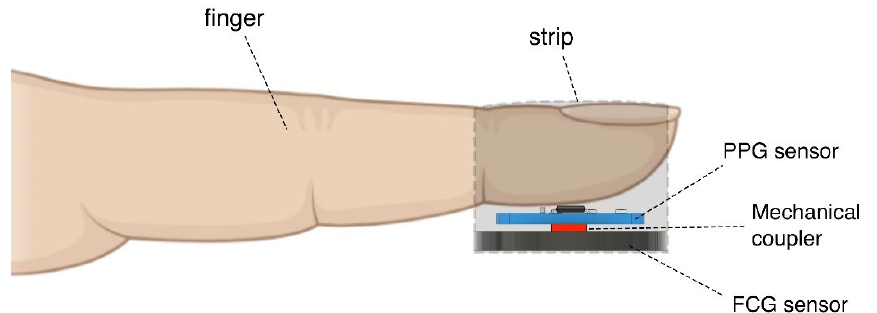
Figure 1. Schematic representation showing the components of the multimodal PW sensor placed on a subject’s finger, namely MAX30102 PPG sensor, piezoelectric FCG sensor, and a flat cylinder acting as a mechanical coupler to ensure reasonable force transduction from the PPG sensor to the FCG sensor.